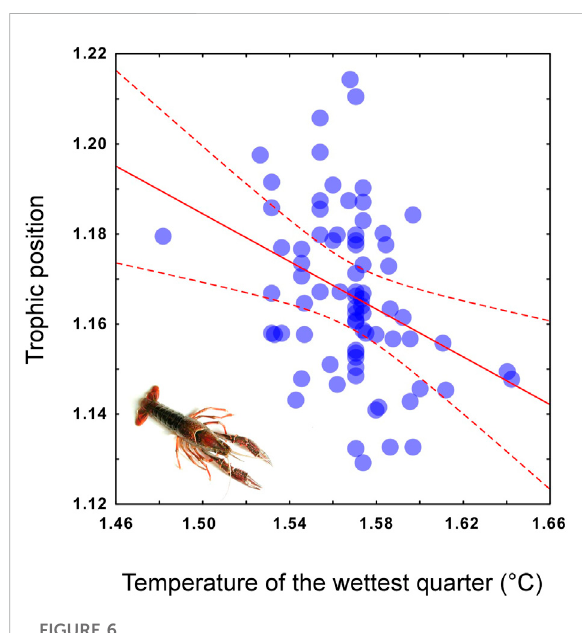
FIGURE 6 Trophic position of Procambarus clarkii calculated from the population-scale dataset as predicted by local mean temperature of the wettest quarter values. For the regression curve (solid line) 95% con fi dence intervals are included (dashed line). Log- transformed and mean-centered data are used in the